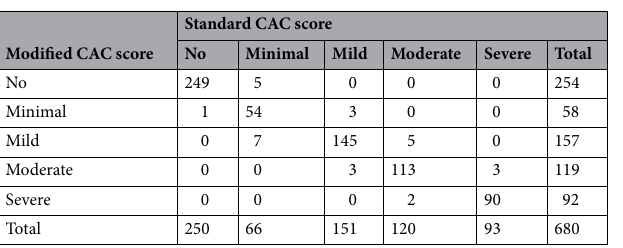
Table 3. For the training set, 29 (4.2%, 29/680) participants showed changes in risk categories with the modified CAC score, and excellent agreement (κ = 0.943) between the standard and modified CAC scores. Inter‑test and inter‑observer agreements. The subpopulation from the training set selected for the inter-test agreement and inter-observer agreements consisted of 70 participants (10.3%, 70/680) (37 men and 33 women; mean age, 56.5 ± 12.6 years; range, 20–78 years). Inter-test agreement was excellent (ICC = 1.000) for the standard CAC score between our in-house software (median, 14.9; IQR, 0.0–69.9) and the commercially availa- ble workstation (median, 15.2; IQR, 0.0–70.3). The median standard CAC score of the additional observer using our software for the same subpopulation was 14.9 (IQR, 0.0–69.9), and inter-observer agreement was excellent (ICC = 1.000). The median values of the modified CAC score for the two observers were 14.9 (IQR, 0.0–70.0) and